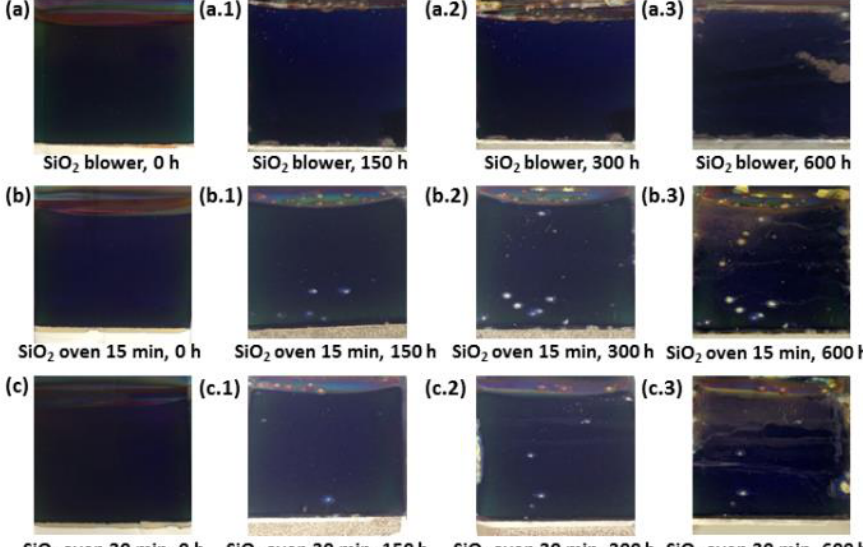
Figure 9. Photographs of Al/CuMnO x /CuFeMnO x /SiO 2 samples with different sintering process of the silica layer before condensation test ( a – c ), after 150 h condensation exposure ( a.1 , b.1 , c.1 ), after 300 h condensation exposure ( a.2 , b.2 , c.2 ) and after 600 h condensation exposure ( a.3 , b.3 , c.3 ). After each testing time in the weathering chamber, the reflectance spectra of the samples were also measured and the absorbers’ optical performance was